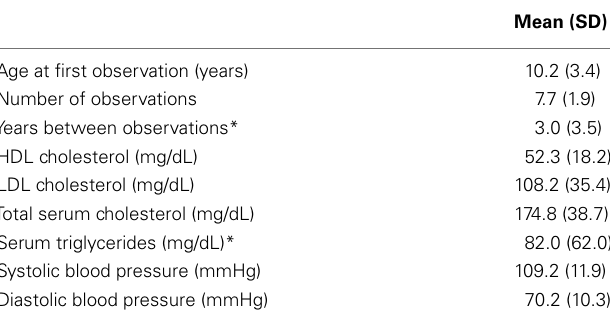
Table 1 | Sample summary statistics ( n = 523).